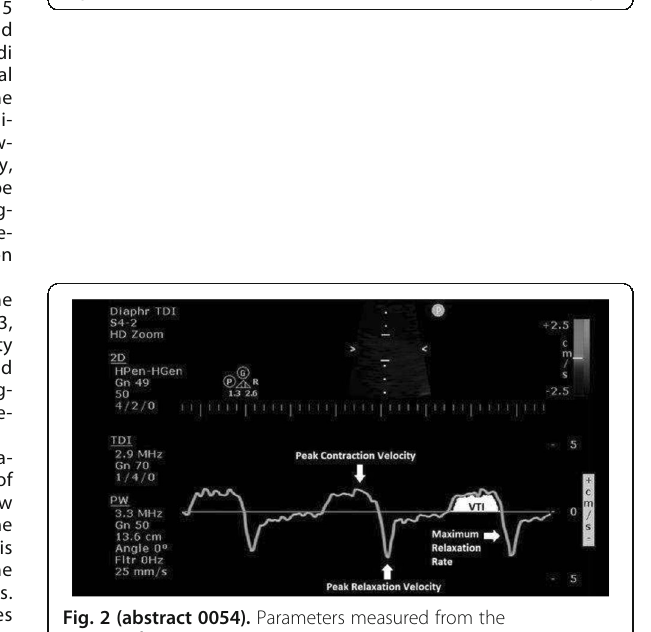
Fig. 1 (abstract 0054). Parameters measured from the Pdi tracing